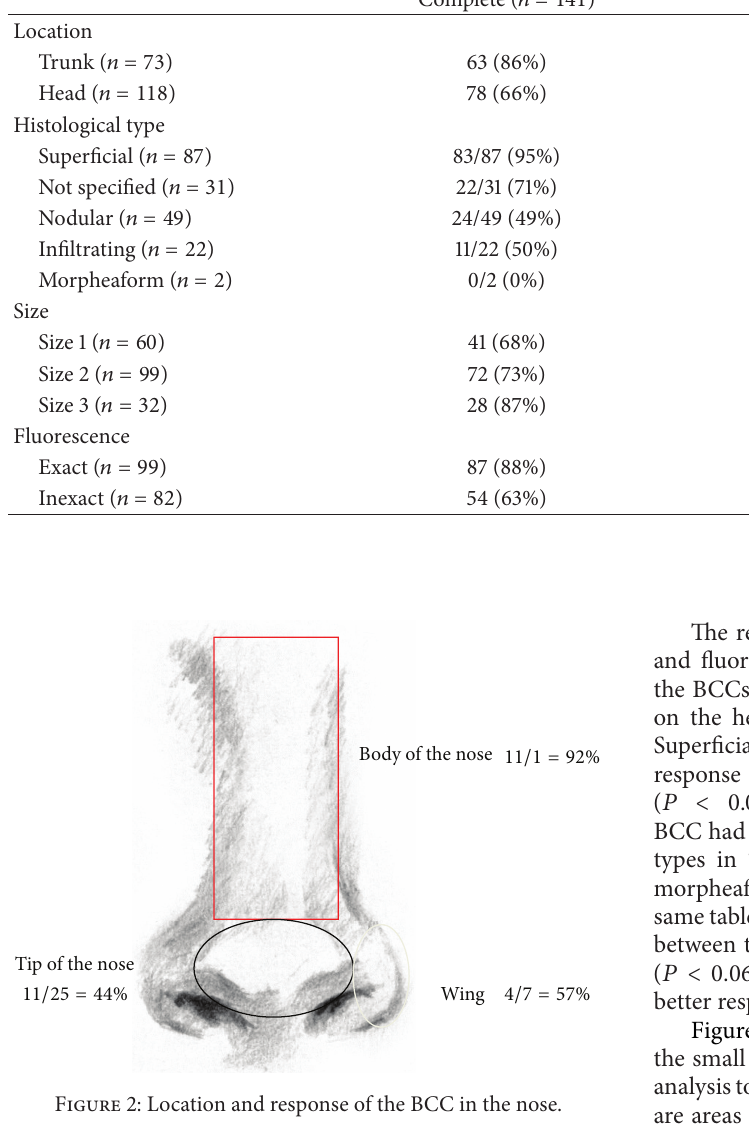
not observed in any cases. Exact fluorescence is much more frequent on the trunk ( 𝑃 < 0.000 , 65%) than the head, where excessive fluorescence was more frequent